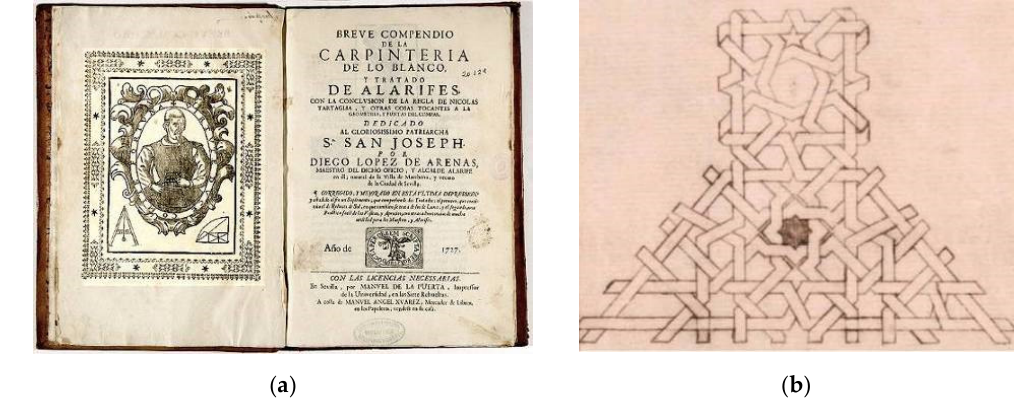
Figure 4. ( a ) Cover of the book by Diego López de Arenas (1633; reissue 1727). ( b ) Plate 15r.